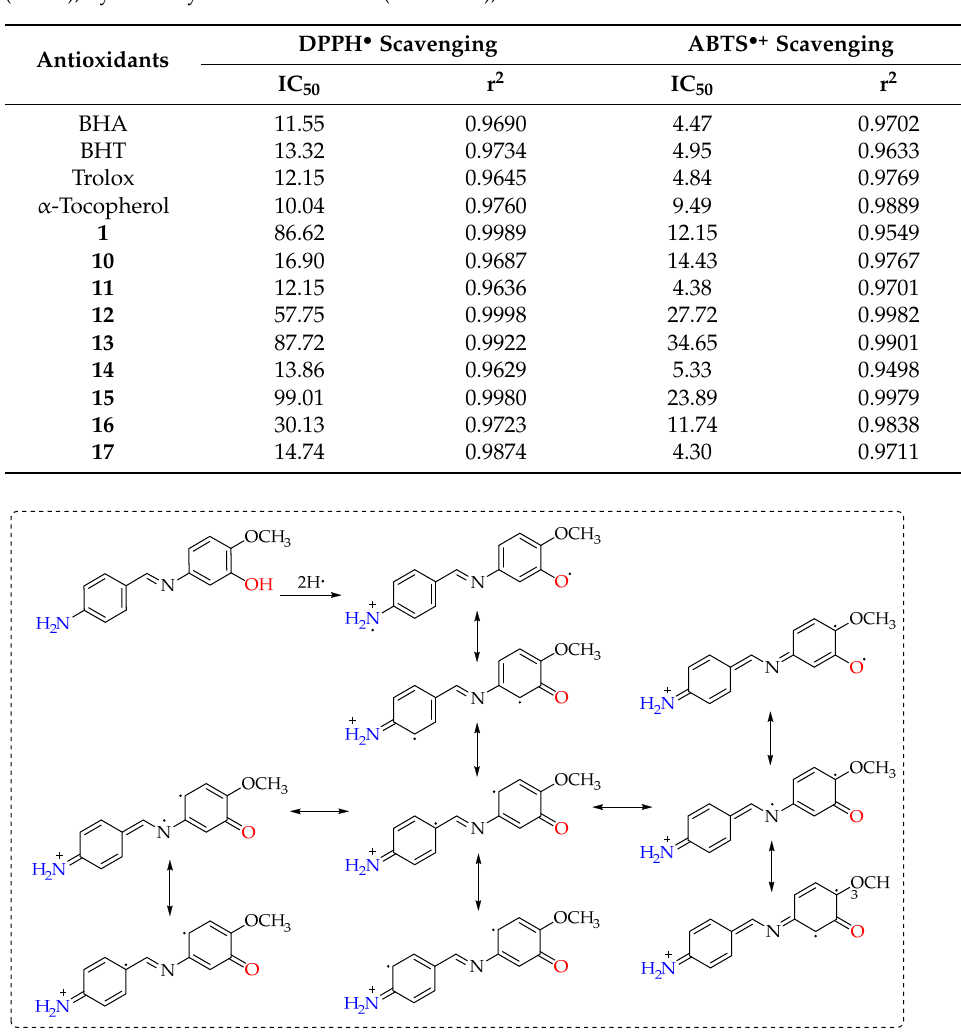
Table 2. IC 50 ( µ g/mL) values for DPPH • and ABTS • + scavenging abilities of some Schiff bases ( 10 – 15 ), hydrazineylidene derivatives ( 16 and 17 ), and